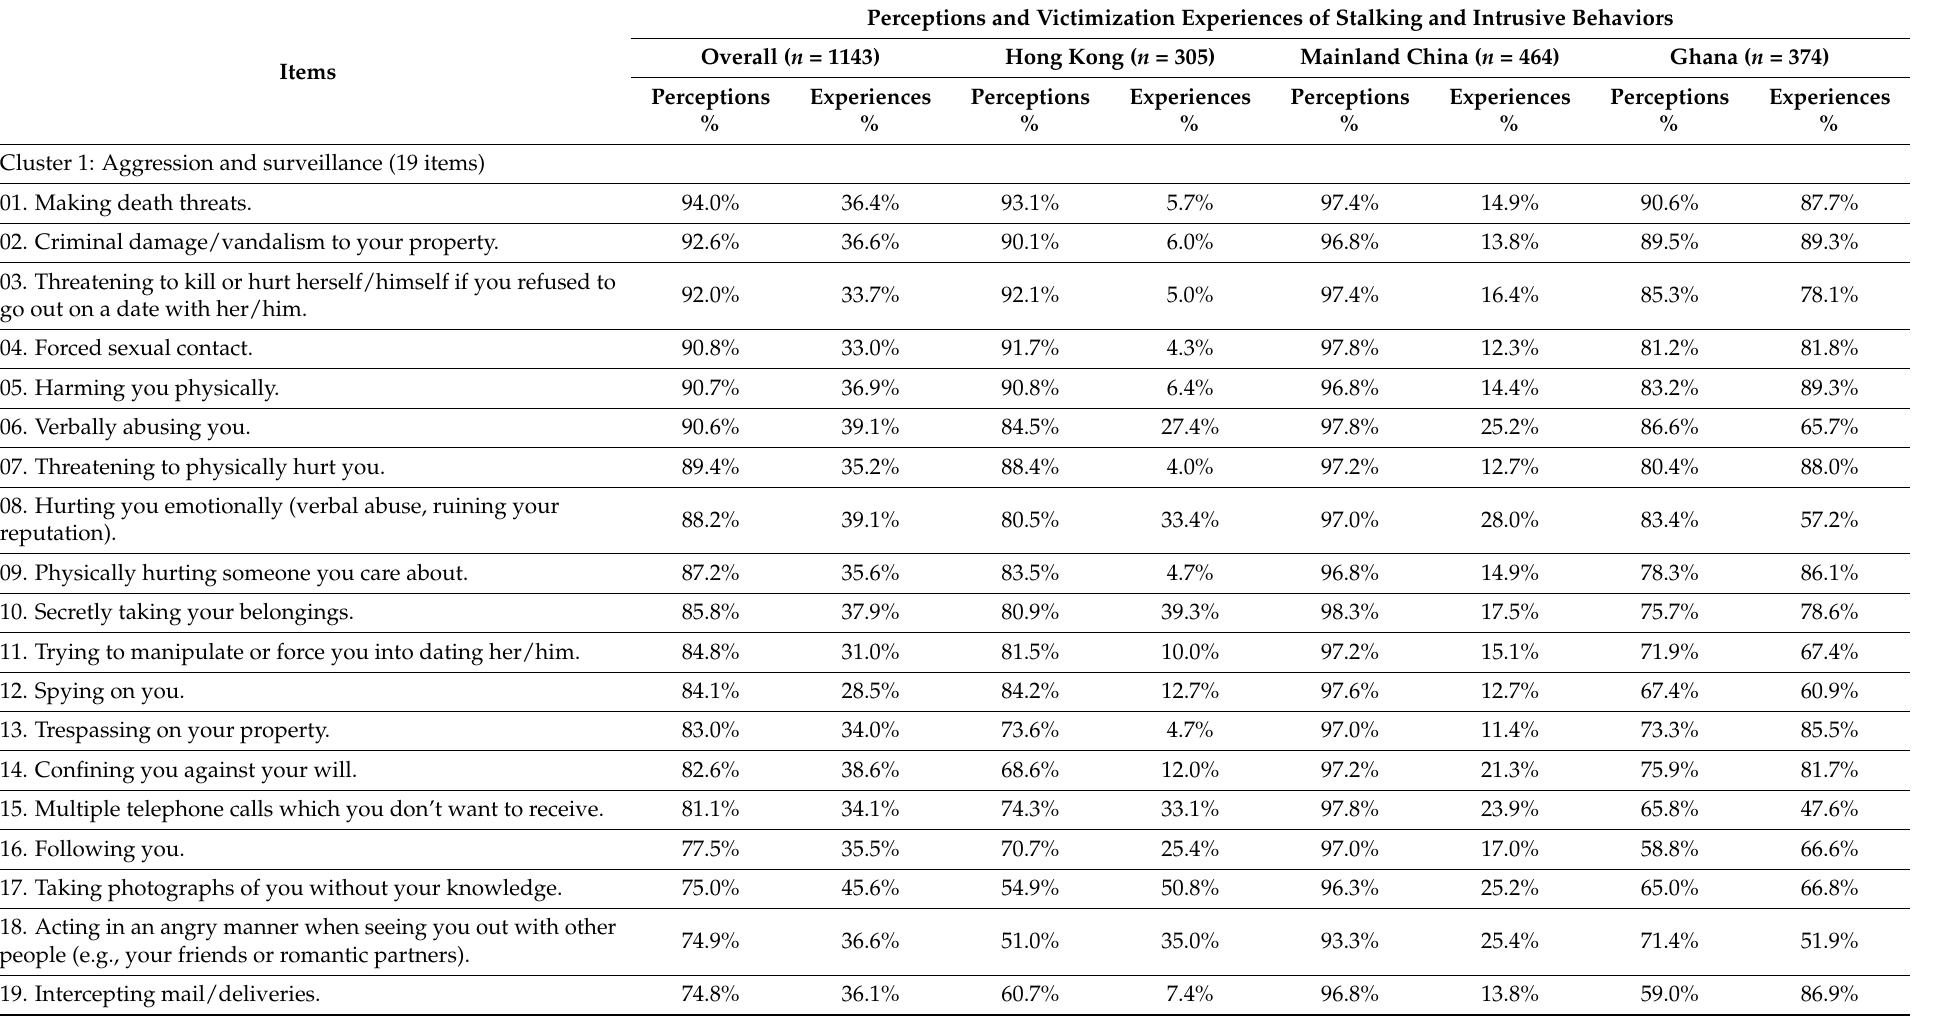
Table 5. Geographical distribution of perceptions and victimization experiences of stalking and intrusive behaviors ( n = 1143). Perceptions and Victimization Experiences of Stalking and Intrusive Items